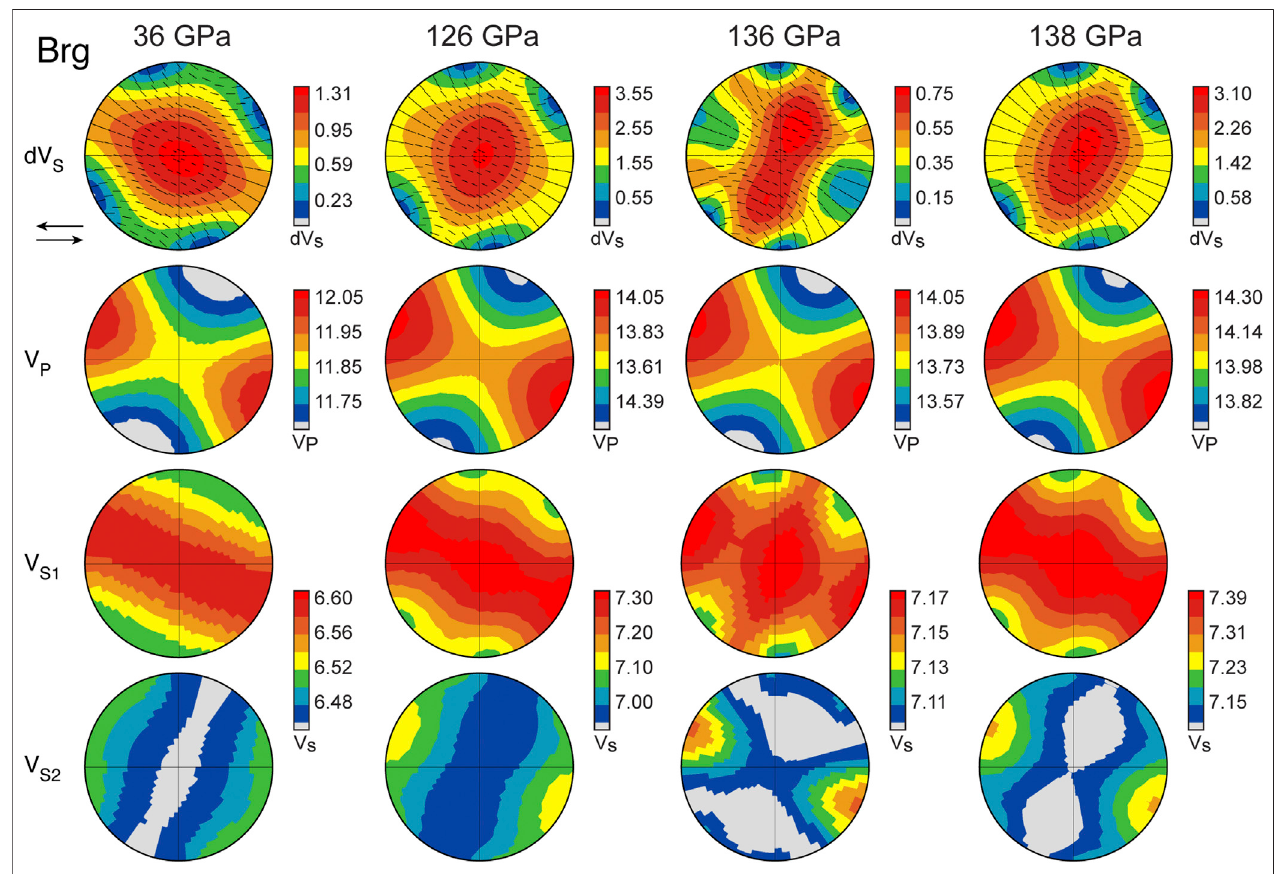
FIGURE8| Stereo-plots(producedbyBeartexsoftware)ofshearwavesplitting( δ V S inpercent),P-wavevelocity(V P inkm/s),thefastshearwave(V S1 inkm/s),and the slow shear wave (V S2 in km/s) for a bridgmanite aggregate at 100% strain. Visco-plastic self-consistent textures used to create the stereo-plots are from our results for theslipsystem pair(100)[010] +(100)[001] when extrapolated topressureand temperature conditions of36 GPaand 2,000 K,126 GPa and 2,800 K,136 GPa and 4,000 K, and 138 GPa and 3,500 K. Elastic constants used to create velocity surfaces are summarized in Supplementary Table S3 . Sense of shear is top left, shown by the arrows. Eigenvectors of the fast S-wave polarization are shown as black dashes. Note that each hemispheric projection shows a different range of δ V S .